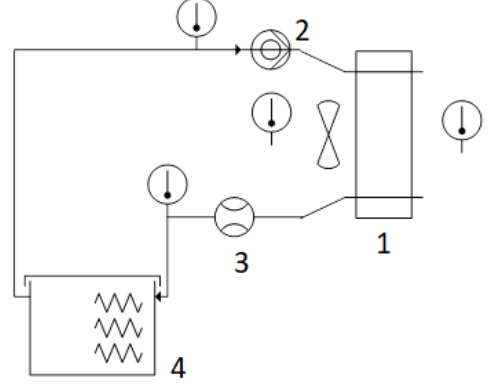
Fig. 4. A schematic diagram of the test stand: 1 – radiator, 2 – pump, 3 – flow meter, 4 – buffer tank